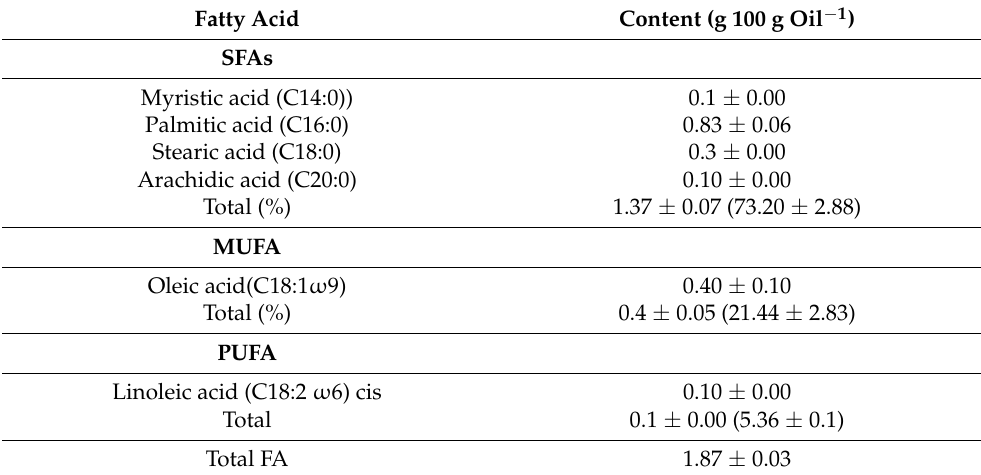
Table 3. Fatty Acid composition of analysed P. tetrastromatica